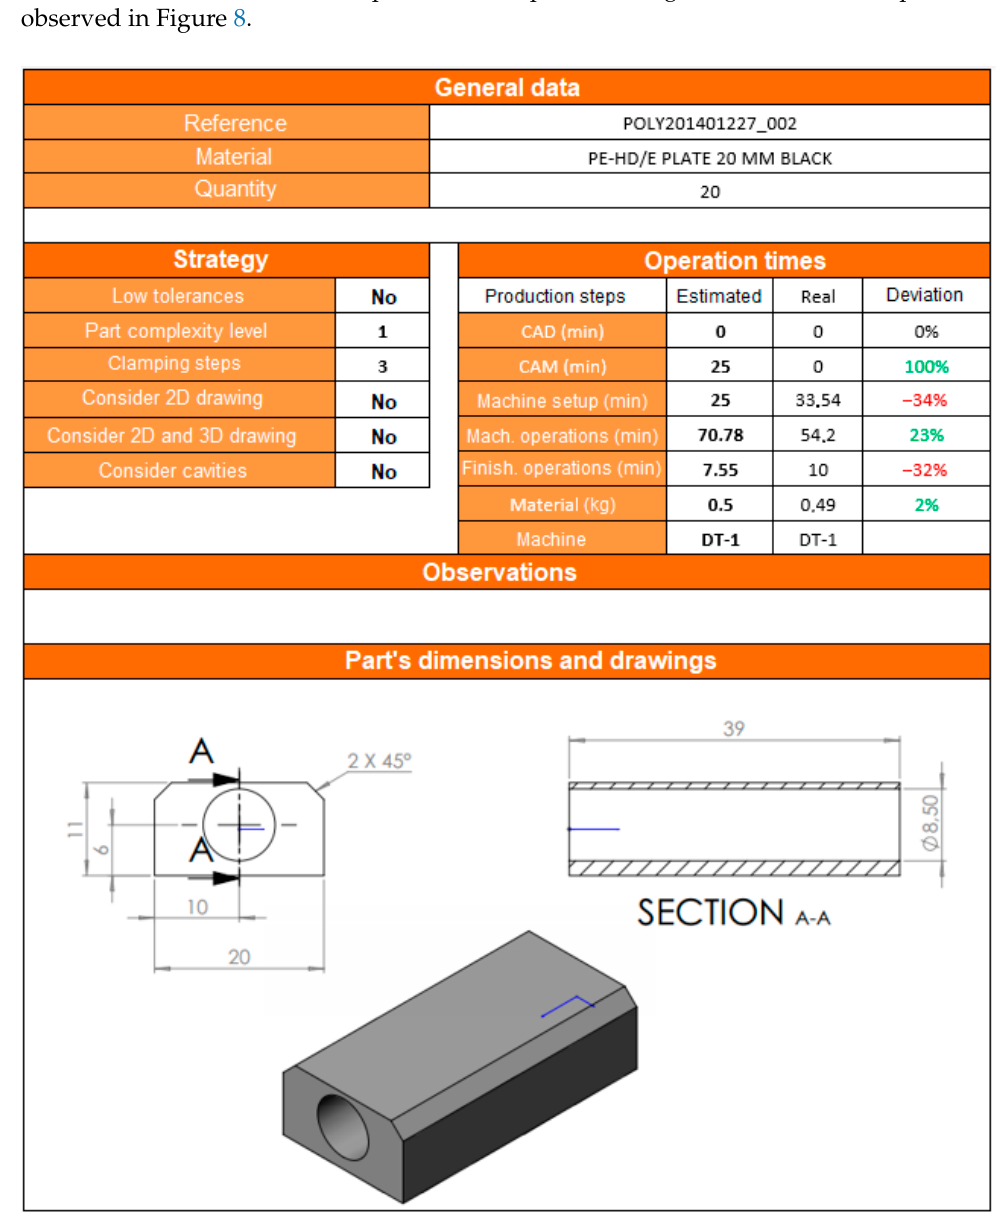
Figure 8. Output sheet of a machined polyethylene part produced for Case Study 1.